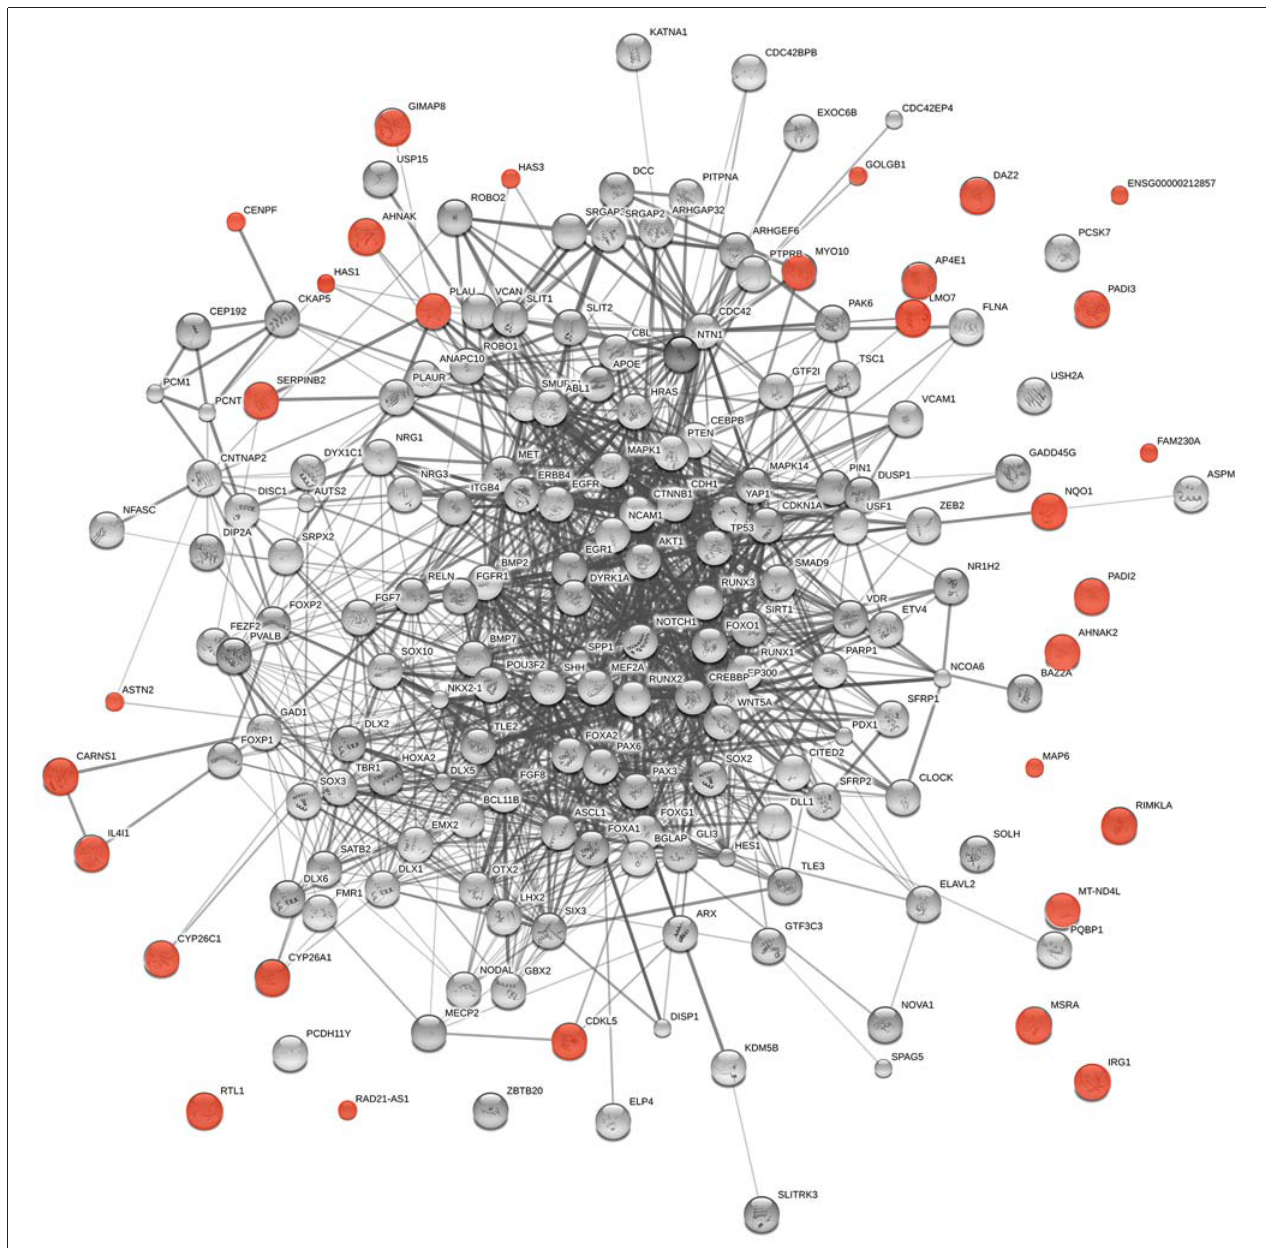
FIGURE 4 | Functional links predicted by String 10 among core candidates for language evolution (nodes in gray) and the horizontally-transferred genes from non-viral organisms highlighted here as potential new candidates for language evolution (nodes in red) . The medium confidence value was 0.0400. The caveats noted for Figure 3